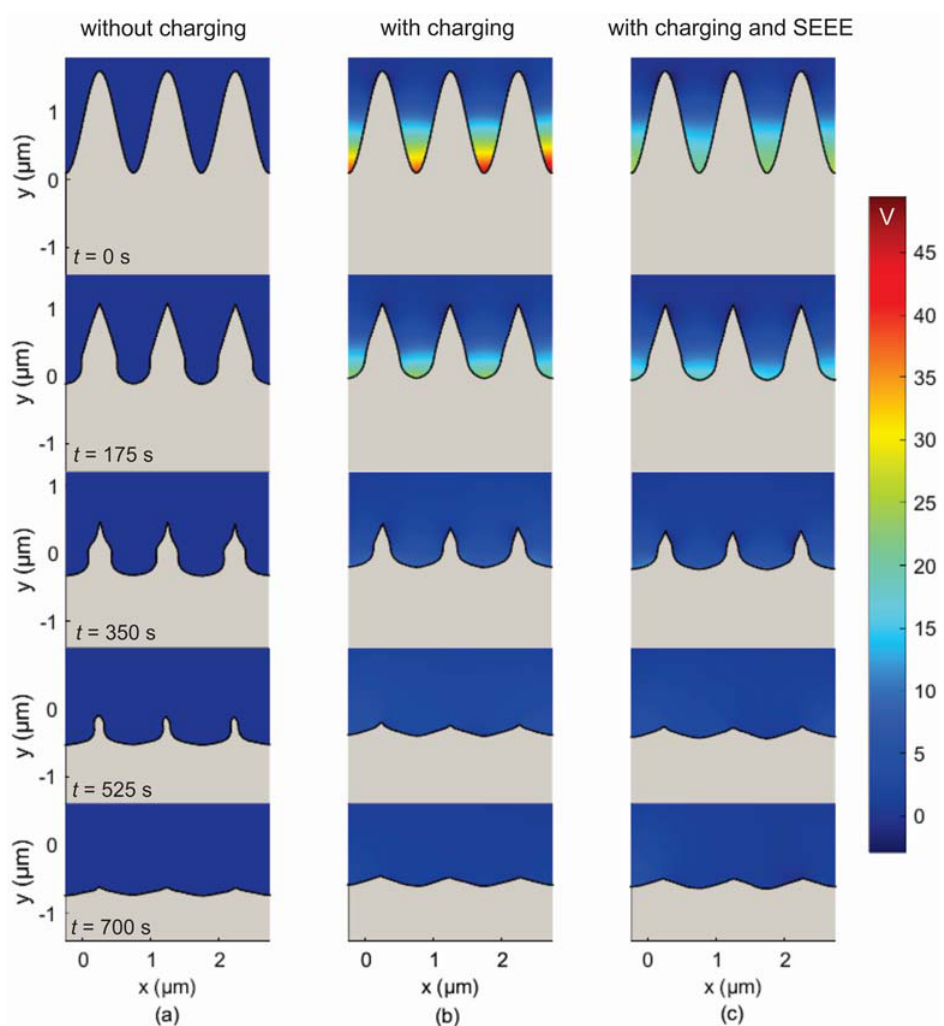
Figure 5. Snapshots of the surface profile for different etching times ( a ) without charging (multimedia view, please see Figure5a.avi), ( b ) with charging (multimedia view, please see Figure5b.avi), and ( c ) with charging and SEEE (multimedia view, please see Figure5c.avi), when the ion reflection is not taken into account. The profiles are cut from the middle of the first valley to the middle of the last one. The charging potential for the snapshots of Figure 5b,c is also depicted. In Figure 6 the same results as in Figure 5 are shown, including the ion reflection mechanism.